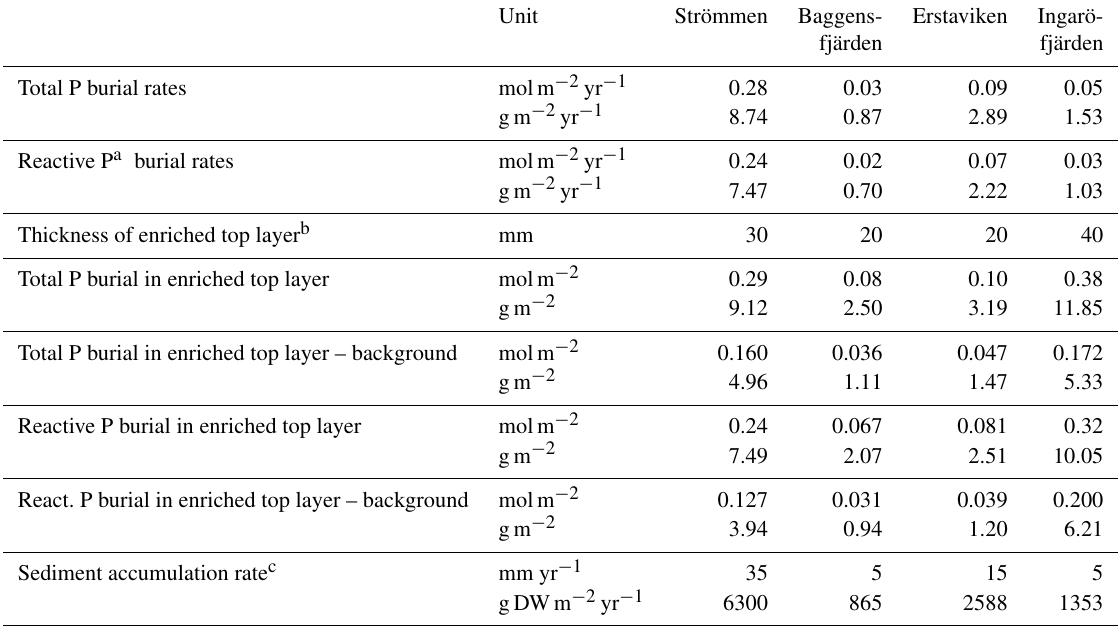
Table 6. Burial rates of total and reactive P.